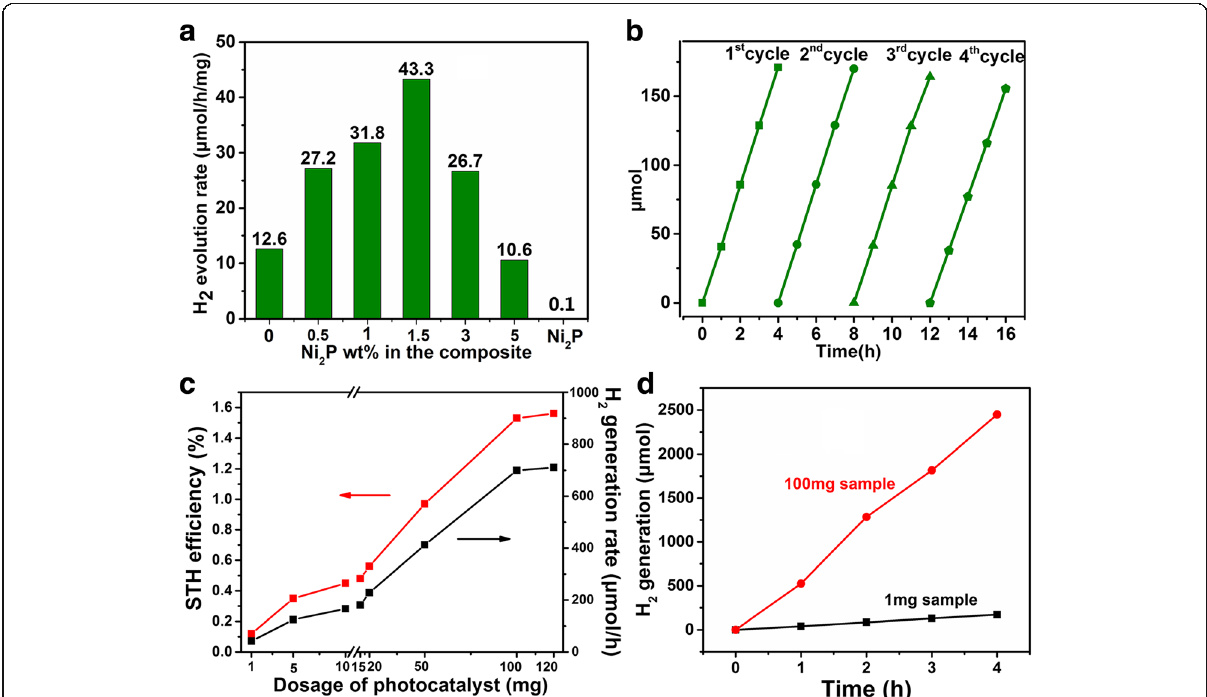
Fig. 3 Photocatalytic property of Ni 2 P-Cd 0.5 Zn 0.5 S composites. a Photocatalytic hydrogen generation at different wt% of Ni 2 P and b the cycling test of the composite with 1.5 wt% of Ni 2 P tested in a small reactor (40 mL, 1.0 mg photocatalyst). c Hydrogen production rate and solar to hydrogen efficiency (STH) at various amount of photocatalyst. The tests for the photocatalyst of dosage from 15 to 100 mg were carried out in a 150 mL reactor, and those of dosage from 1 to 10 mg were in a 40 mL reactor. d The hydrogen generation rate for 1 and 100 mg composite samples (1.5 wt% Ni 2